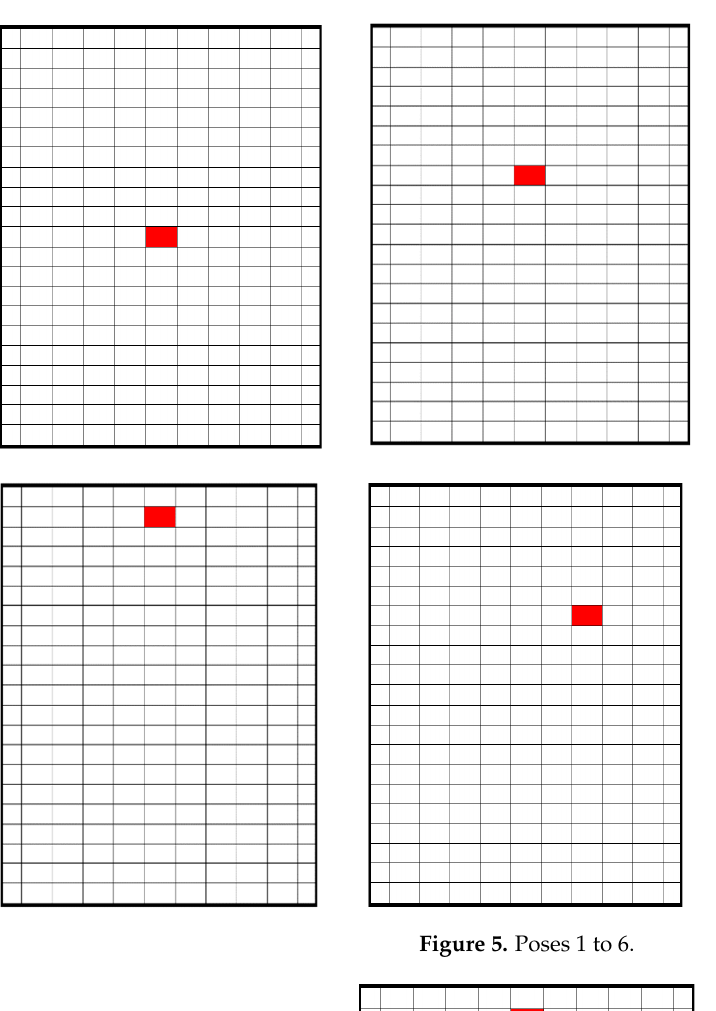
Figure 5. Poses 1 to 6.